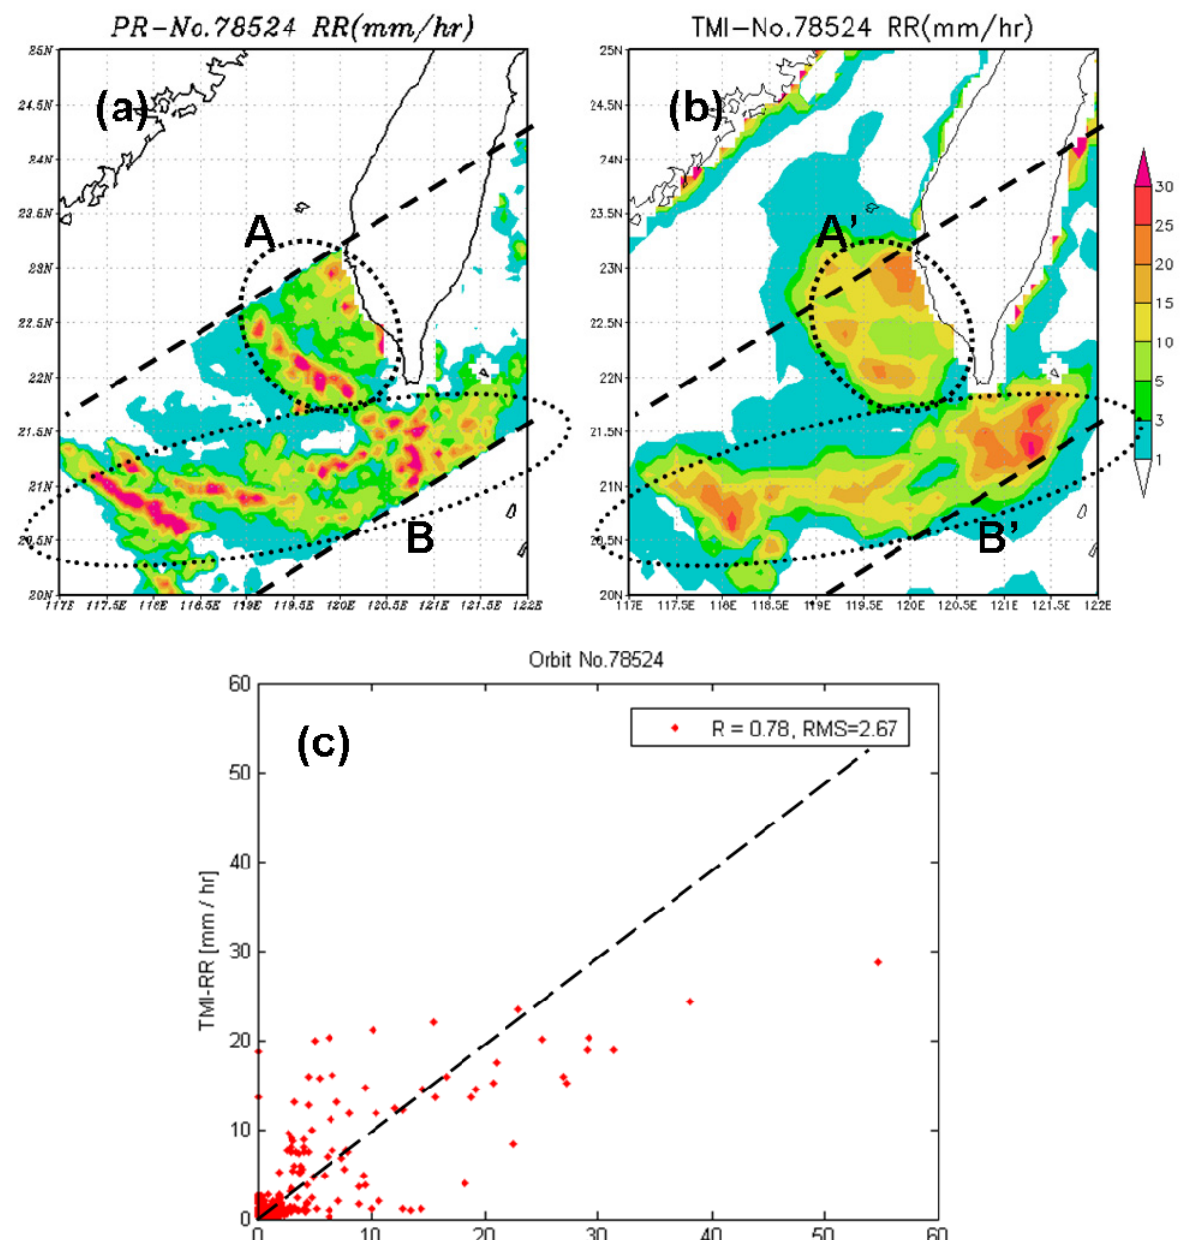
Figure 13. RR estimation for Typhoon Nanmadol: ( a ) near-surface RR estimated by the PR (PR-RR); ( b ) RR estimated using the Bayesian method and the TMI data (TMI-RR); and ( c ) scatter plot of the PR-RR and